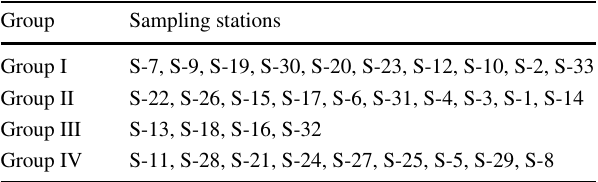
Table 6 Groups showing similar types of groundwater quality in the study